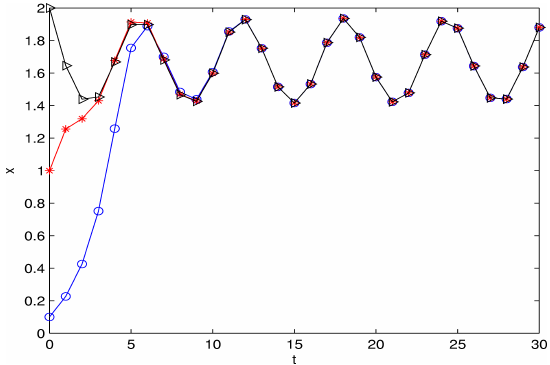
Fig. 3. Graphs of the solution x ( t ) of (24) with α = 0.7 and the initial values x ( 0 ) = { 0.1,1,2 }